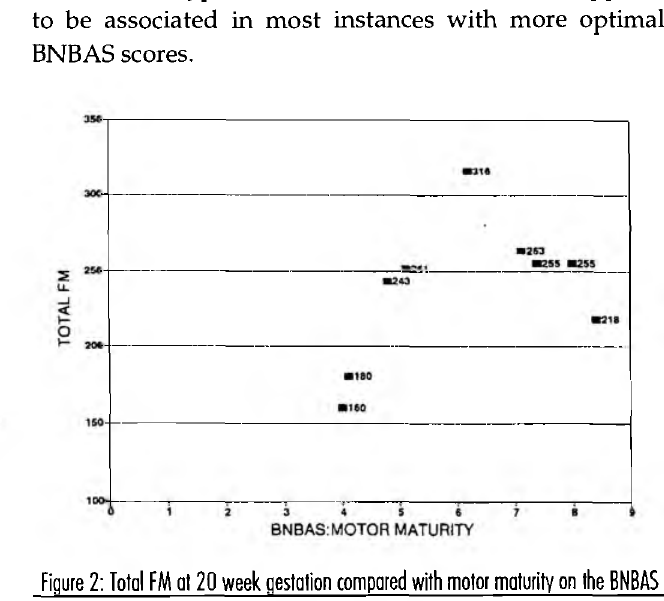
Figure 2: Total FM al 20 week gestation compared with motor maturity on the BNBAS Comparative performances of black c/f white infants